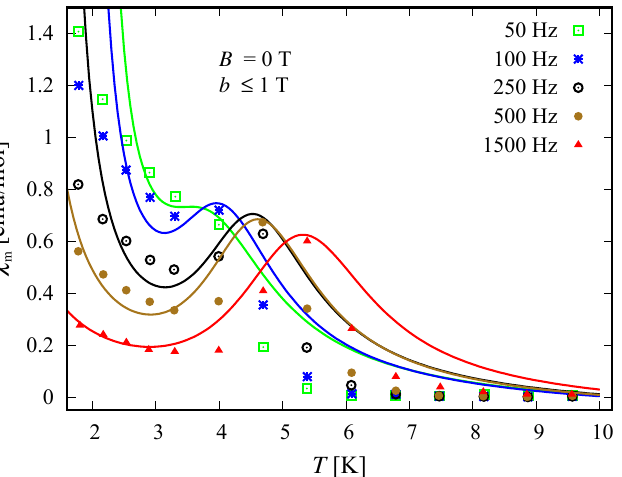
Figure 9. Out-of-phase susceptibility of the compound Na 9 [Er(W 5 O 18 ) 2 ] as a function of the temper- ature. The experimental and theoretical results are shown by symbols and solid lines, respectively. Experimental data are taken from Reference [9]. Calculations are performed using (12) and the spin–sigma model (1), with the magnitude of the ac field b ≤ 1